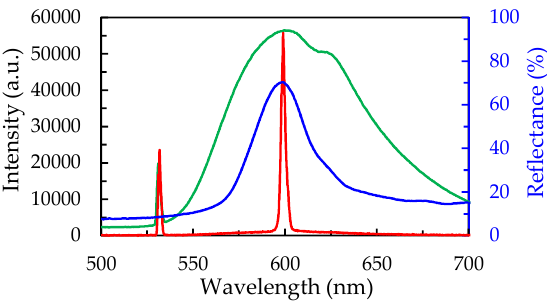
Figure 3. The spectral overlap of the fluorescence (green line), reflection (blue line), and lasing emission (red line) of the SiO 2 photonic-crystal laser.